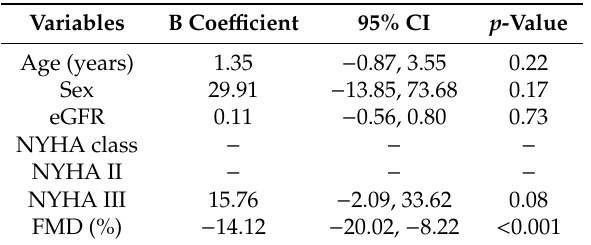
Figure 2. Levels of soluble suppression of Tumorigenesis-2 are inversely associated with FMD but not with PWV. ( A ) Scatter-dot of the association of PWV with soluble suppression of Tumorigenesis-2. ( B ) Scatter-dot of the association of FMD with soluble suppression of Tumorigenesis-2. sST2: Soluble Suppression of Tumorigenesis-2; PWV: Pulse wave velocity; FMD: Flow-mediated dilation. Table 2. Multiple linear regression analysis for the association of sST2 (dependent variable) with several variable.